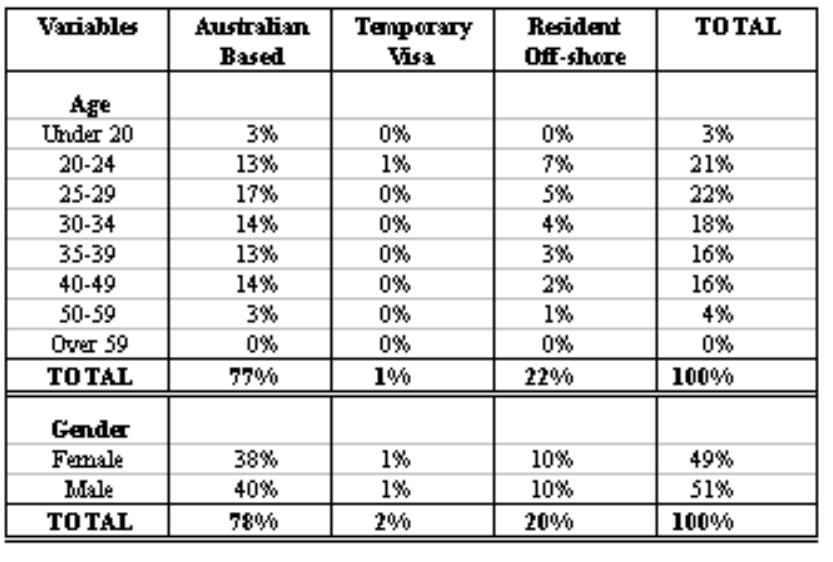
Table 4: Nature of USQ’s Off-campus Student Population: 1999 (Below/End)